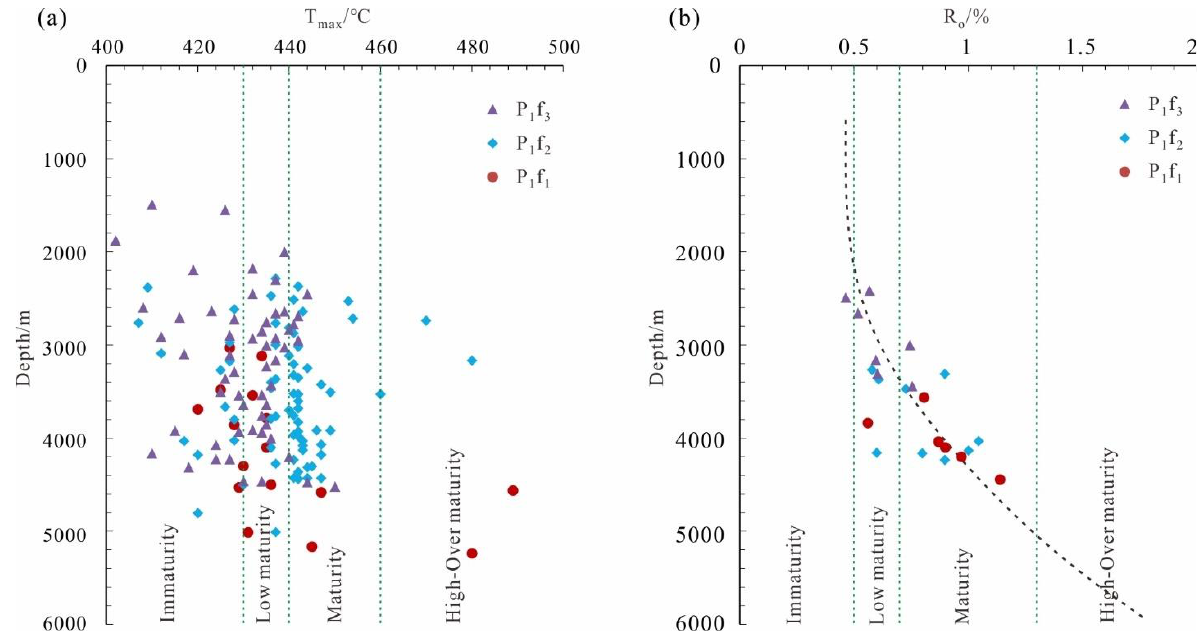
Figure 8. Variation in Maturity of organic matter indicators with depth of source rock in the Feng- cheng Formation of Mahu Sag: ( a ) T max ; ( b ) Ro. Fengcheng Formation of Mahu Sag: ( a ) T max ; ( b )